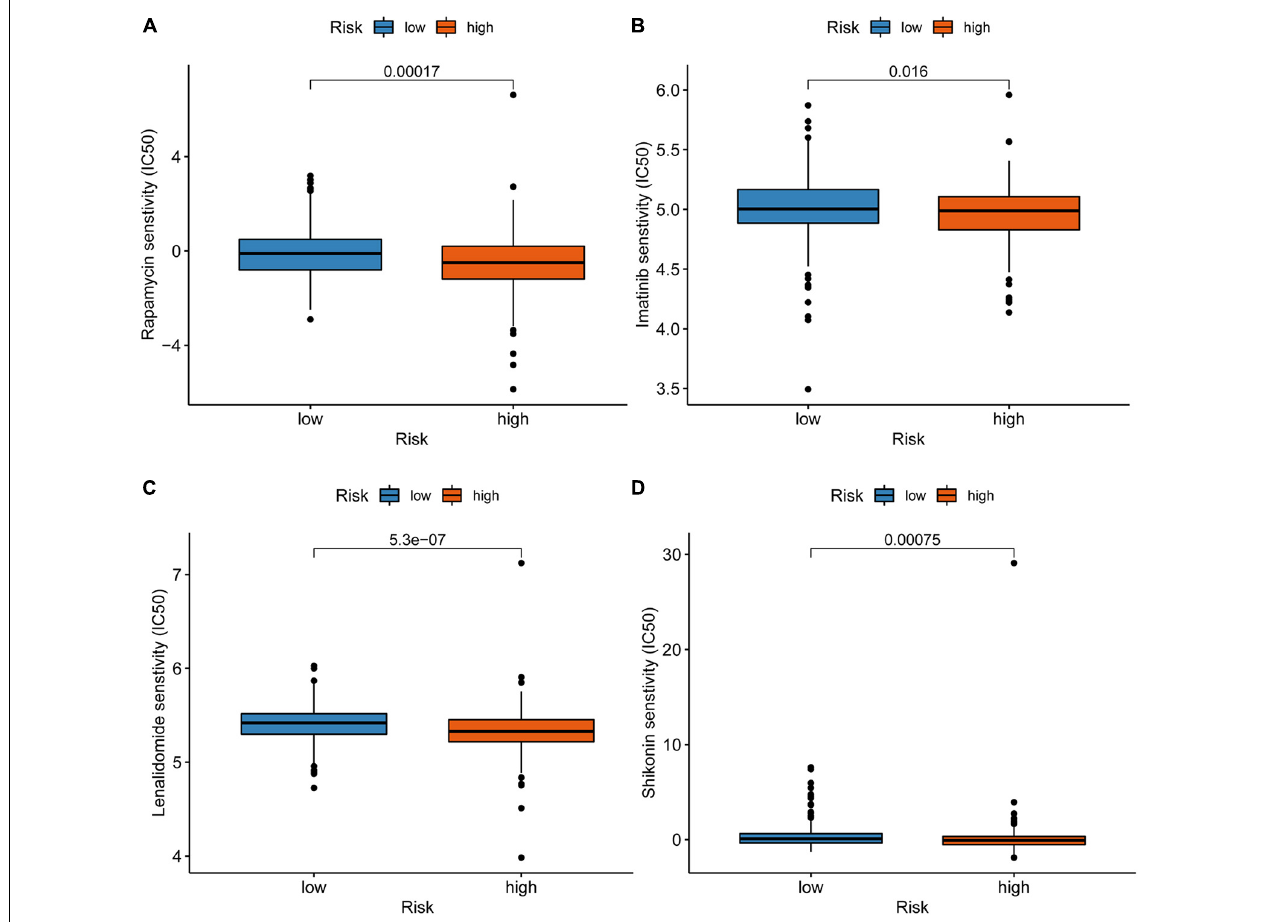
FIGURE 6 | Correlation between the risk model and chemotherapeutics. A high-risk score was associated with lower IC50 for chemotherapeutics such as Rapamycin (A) , Imatinib (B) , Lenalidomide (C) , and Shikonin (D)